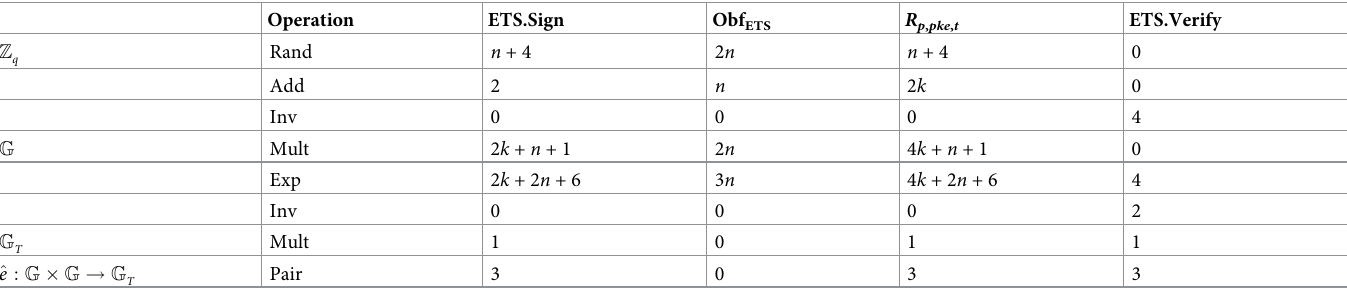
Table 1. Computational overhead, where n is the number of users, k is the threshold